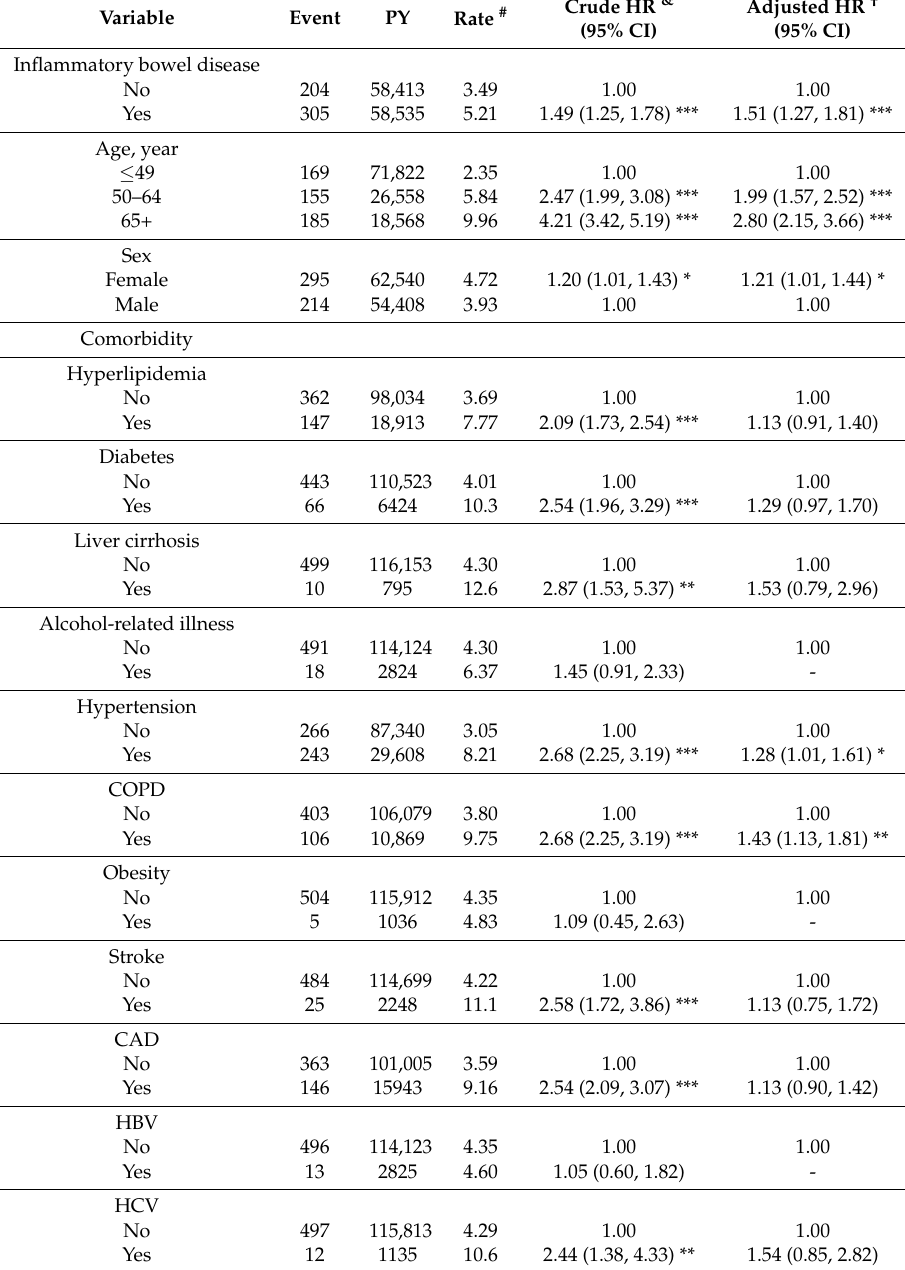
Table 2. Incidence of cholelithiasis and its risk